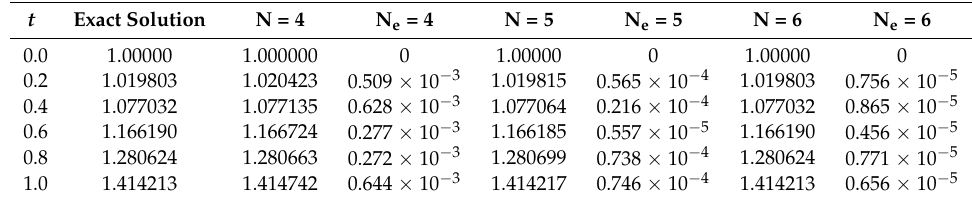
Table 4. Numerical result for approximate solution of y 1 ( t ) in Example 3.